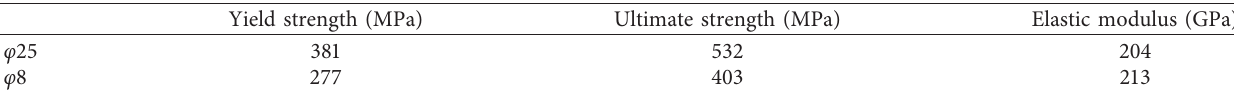
Table 2: Material properties of